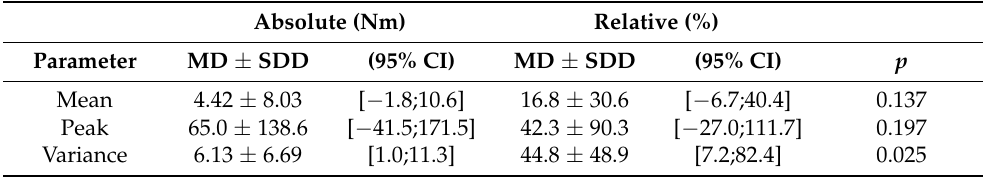
Table 7. Static vs. dynamic tasks. Shown are the absolute (Nm) and relative (%) differences between the static tasks and the dynamic tasks through mean difference (MD: dynamic-static task) and its standard deviation (SDD) plus 95% confidence interval (CI) of these differences for the moment magnitude (||M||) with p -value of paired t